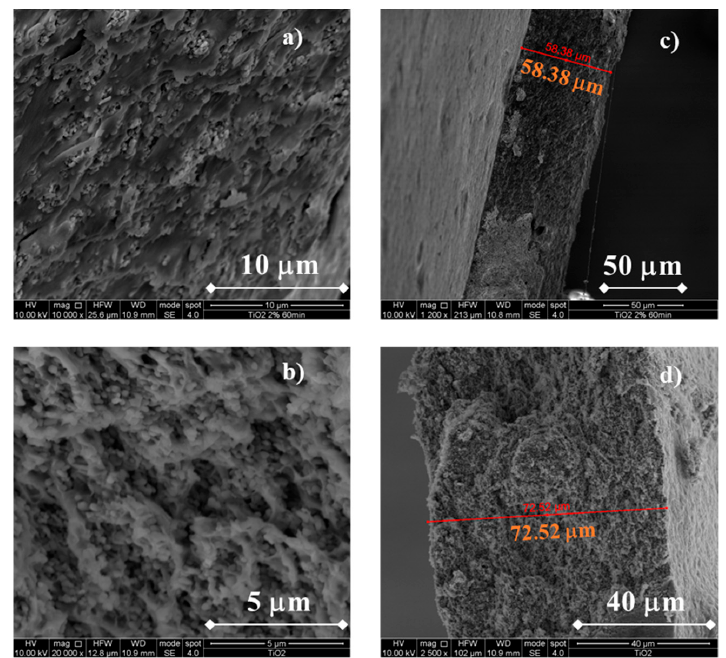
Figure 3. SEM cross-sectional micrograph of a CS/PTA membrane with TiO 2 . Morphology of the ( a ) CS/PTA +TiO 2 (2% wt) membrane, ( b ) CS/PTA + TiO 2 (5% wt) membrane and cross section of the ( c ) CS/PTA + TiO 2 (2% wt) membrane and ( d ) CS/PTA + TiO 2 (5% wt) membrane.